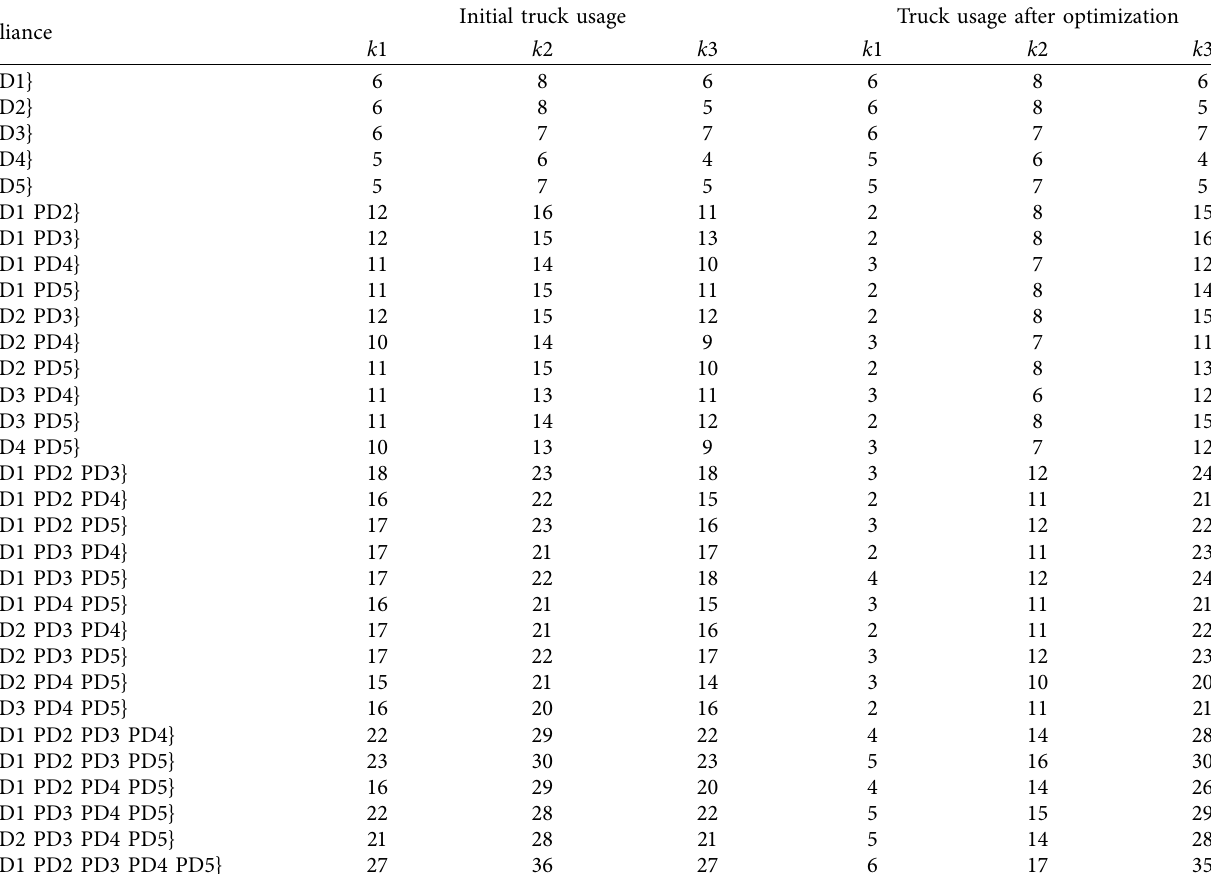
Table 10: Comparison of truck usage between initial and optimized networks